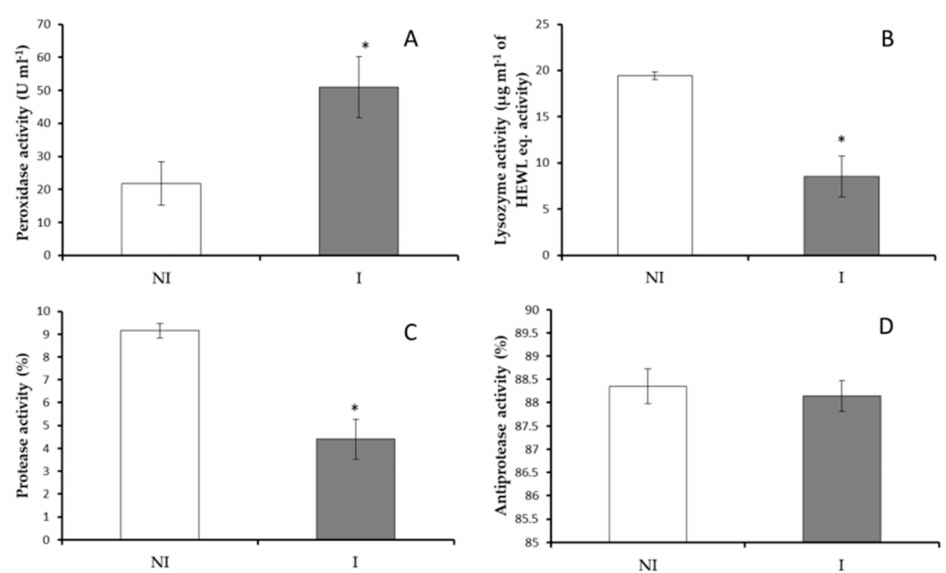
Figure 5. Serum immune response in non-infected (NI) and infected (I) European sea bass. ( A ) peroxi- dase, ( B ) lysozyme, ( C ) protease and ( D ) antiprotease activities. Data are represented as means ± SEM (n = 9). Asterisks denote significant differences between groups ( p <